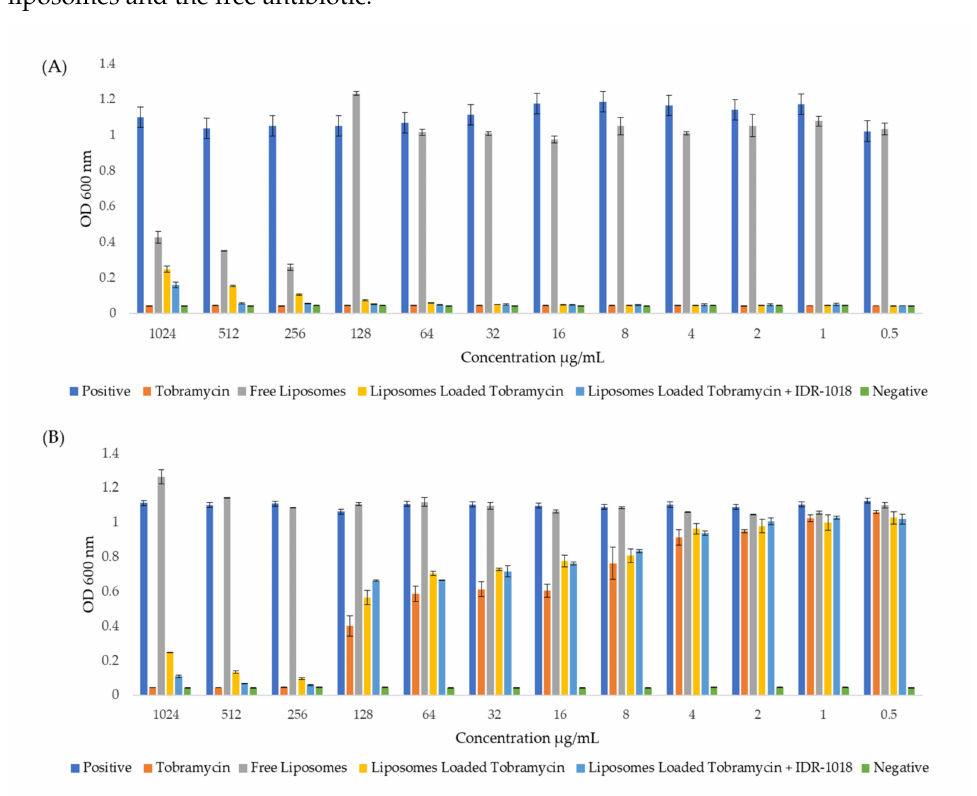
Figure 2. MIC results of different formulations against two P. aeruginosa strains after 24 h exposure. ( A ) The effect of the applied formulations on PA01 that was used as a control strain, in which it was significantly reduced with all tested tobramycin concentrations, while the MIC of the free liposomes was 256 µ g/mL. ( B ) The effect of the applied formulations on MDR 7067 as a resistant strain showed that the free and formulated tobramycin had an MIC of 256 µ g/mL, whereas there was no antibacterial activity for the empty liposomes. Results are represented as mean ± SD (n = 3). OD: optical density. Positive and negative controls are wells containing only bacterium and culture medium, respectively, without adding any